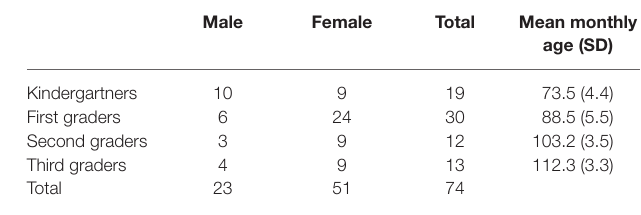
TABLE 1 | Numbers and mean ages (months) of the